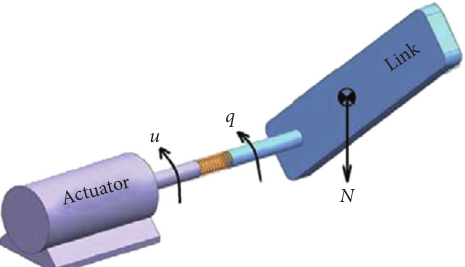
Figure 1: Sketch of one-link manipulator.